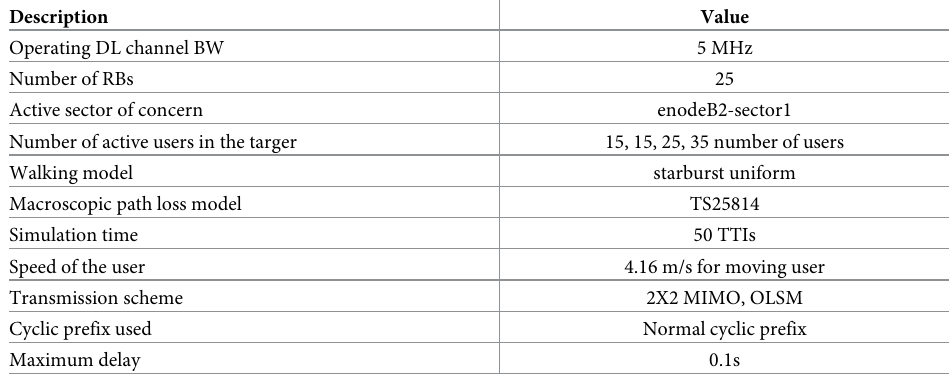
Table 3. Simulation